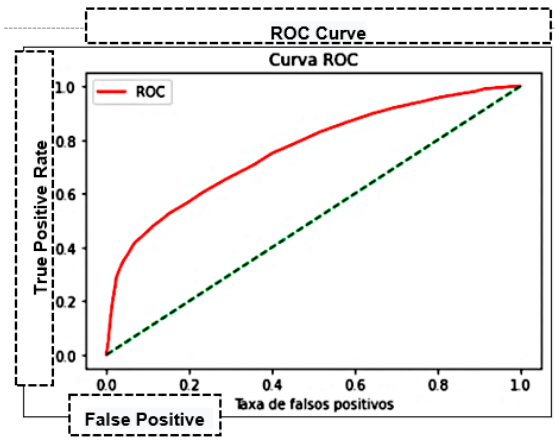
Figure 5. ROC curve—Hamming.